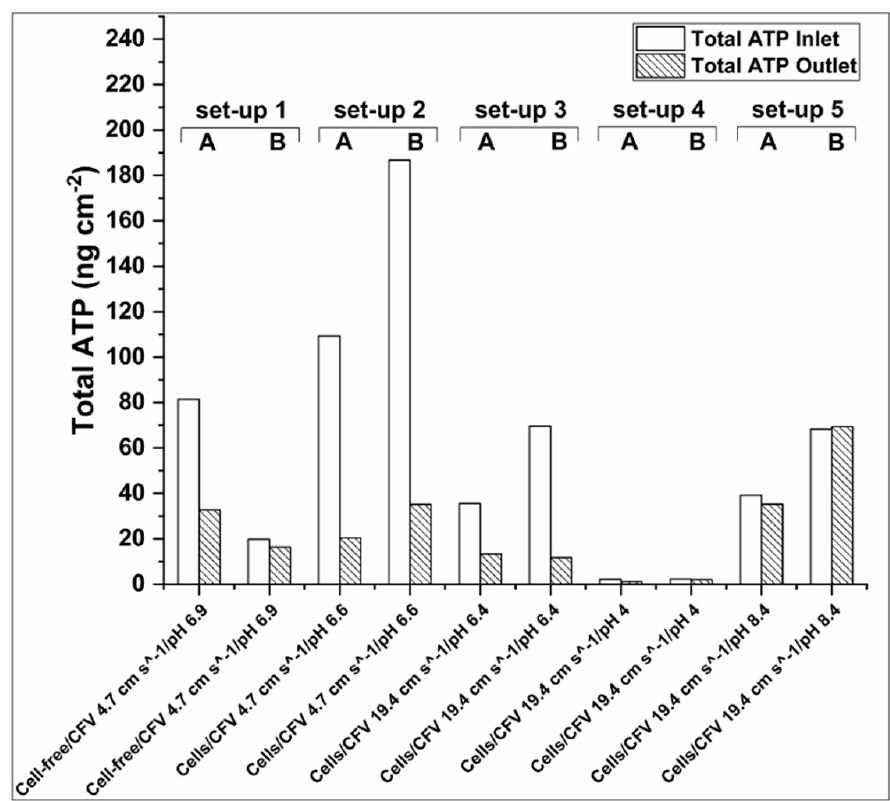
Figure 6. Total-ATP concentration on the inlet and outlet of the membrane patches. For set-ups 1, 2, and 3 there was a general tendency for higher Total-ATP concentration in the membrane inlet, whereas for set-up 5 Total-ATP concentration was similar in both ends of the membrane coupon. Very low amounts